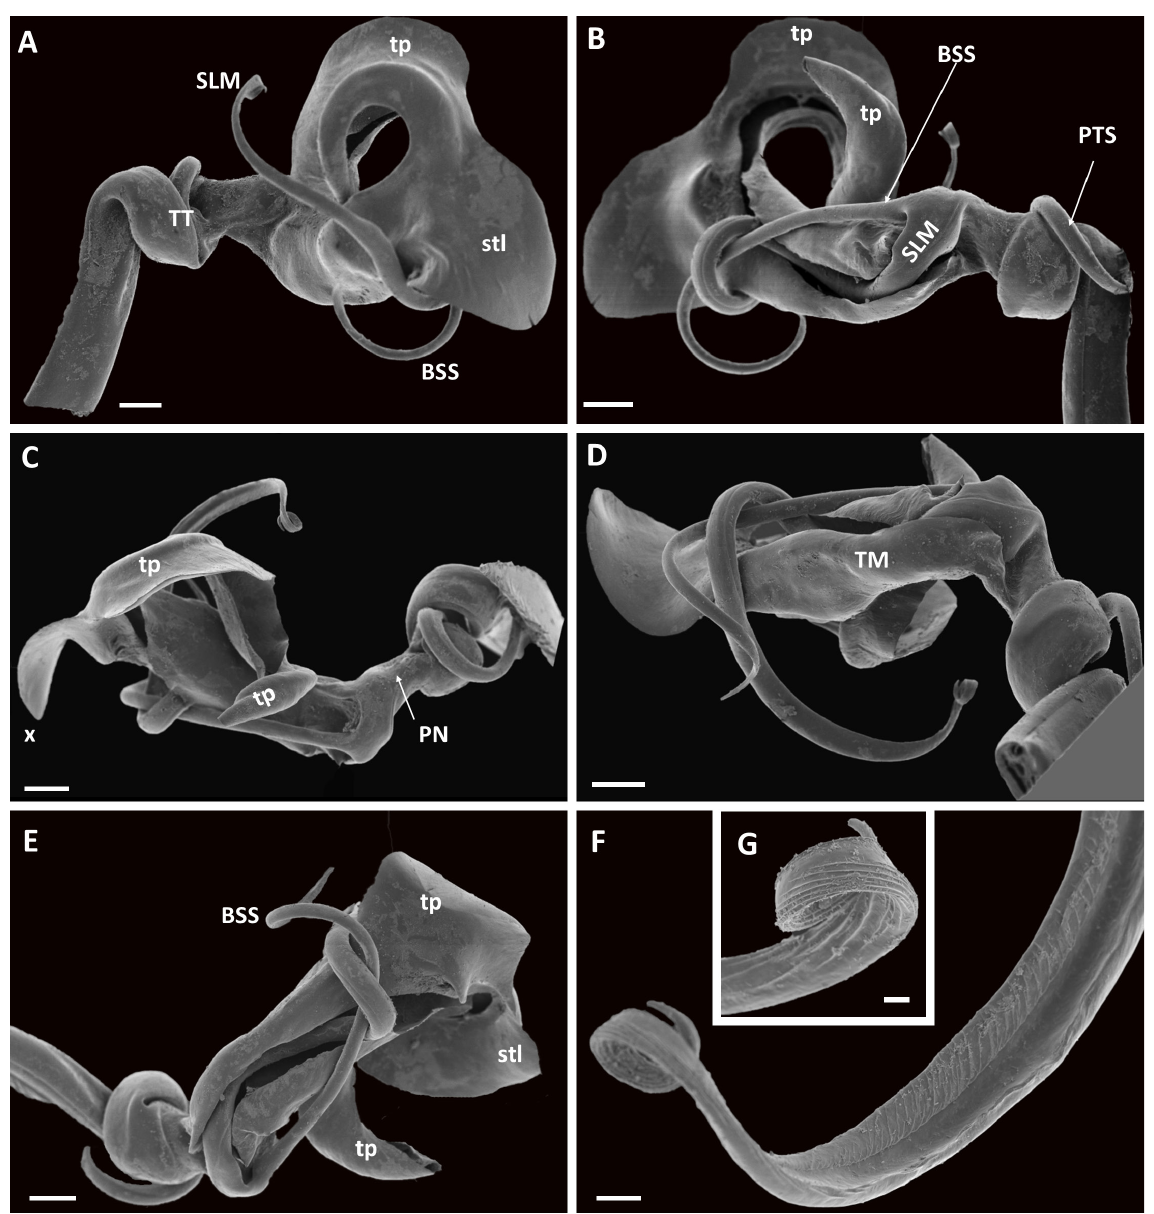
Fig. 42. Lamelloramus frederiksenae sp. nov., holotype, ♂ (NHMD 621744), left gonopod telopodite. A . Anterior view. B . Posterior view. C . Distal (ventral) view. D . Sub-dorsal view (grey area in lower right covered by mounting tape). E . Dorso-anterior view. F – G . Solenomere tip. Abbreviations: BSS = basal solenomeral spine; PN = post-torsal narrowing; PTS = post-torsal spine; SLM = solenomere; stl = ‘side- branching telomeric lamella’; TM = telomere; tp = telomeral process. Scale bars: A–E = 0.2 mm; F = 0.05 mm; G = 0.02